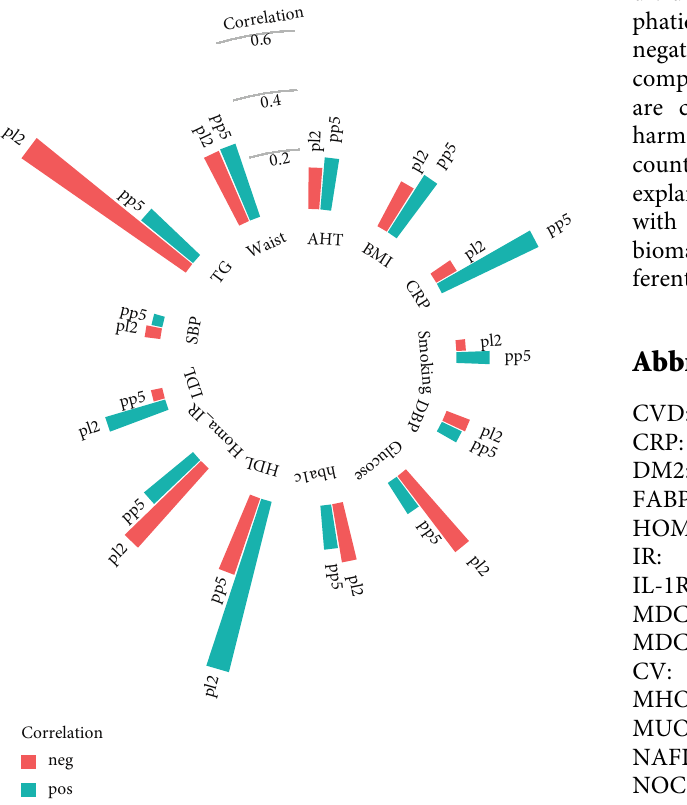
Figure 6: Logistic regression models, with significance testing, of the main PCs when comparing MHO (a) with NOC subjects (b).